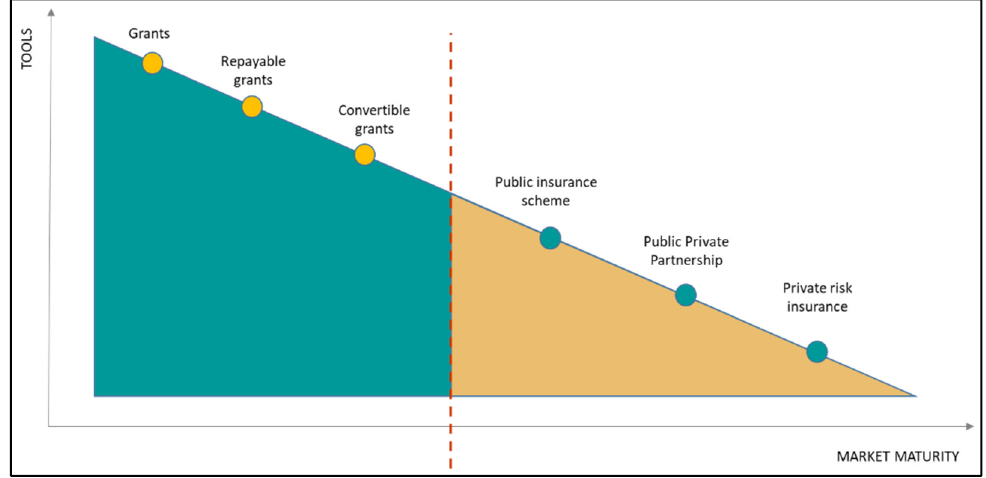
Figure 1. Presentation of an RMS in relation to the market maturity level (source: modified from [4]).